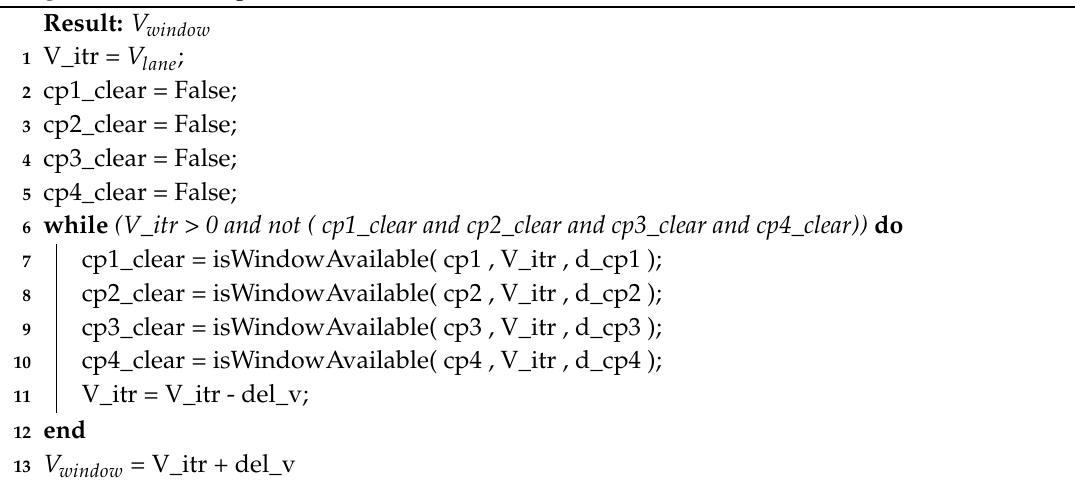
Algorithm 2: The algorithm to find V